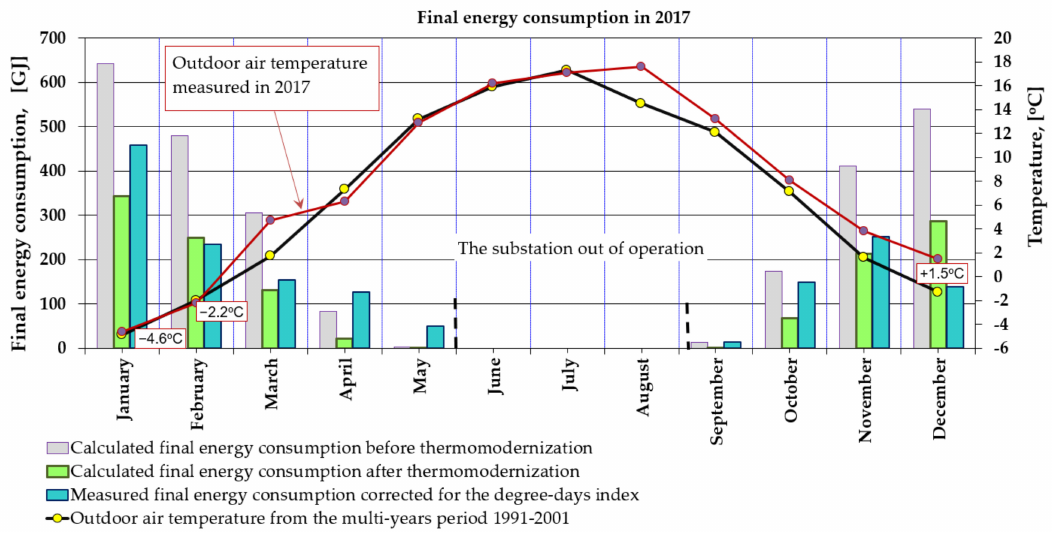
Figure 11. Final heat energy consumed for heating and ventilation needs of building A in 2017 and final energy corrected by the energy index of degree days ∂ together with the monthly outdoor air temperatures recorded in 2017 and the average outdoor air temperature for the multi-year period for the Bialystok weather